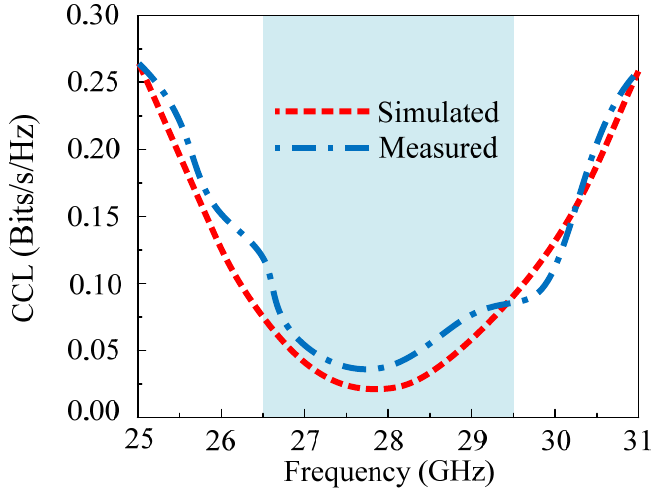
Figure 14. Simulated and measured CCL of the proposed antenna.